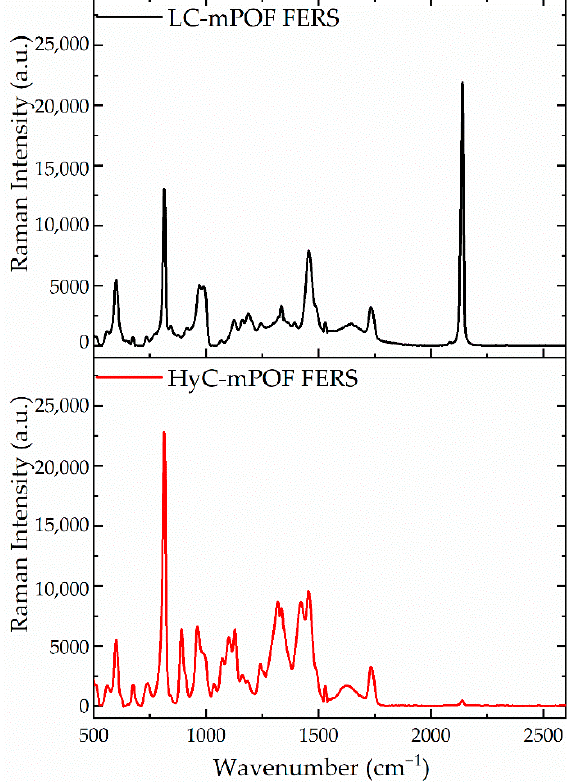
Figure 7. Comparison of two Raman measurements employing a LC-mPOF (black) and a HyC-mPOF (red) during six hours of immersion. In both cases, the Raman peak of the potassium ferricyanide is observed at 2140 cm − 1 but with different intensities.